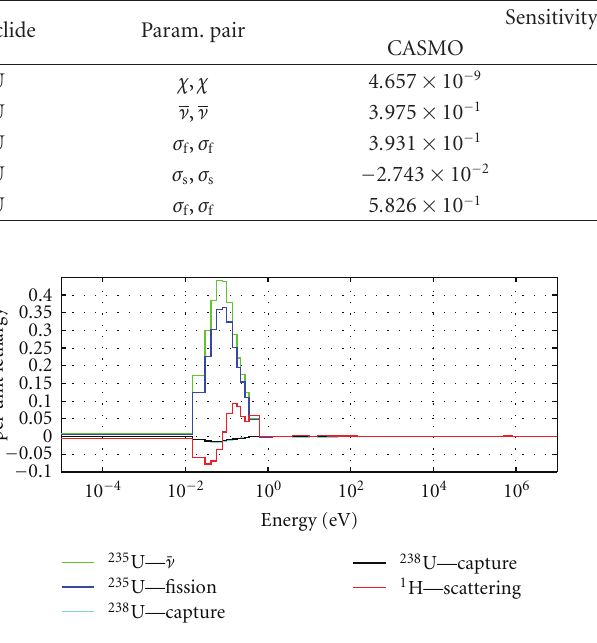
Figure 7: Sensitivity profiles of the response ν Σ f,2